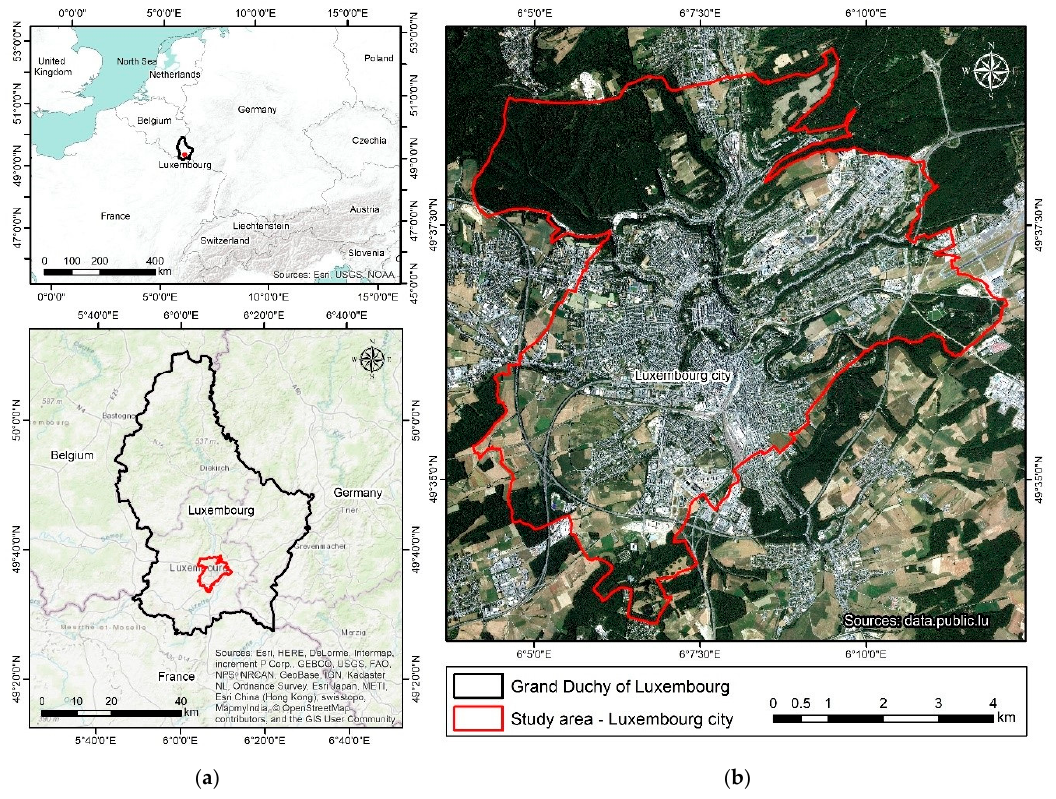
Figure 1. ( a ) Location of the study area. Left top: location of Luxembourg in Europe, left bottom: Grand Duchy of Luxembourg and Luxembourg City borders; ( b ) Orthophotomap of Luxembourg City at municipality level (2019). Table 1. Details of geospatial data used in the